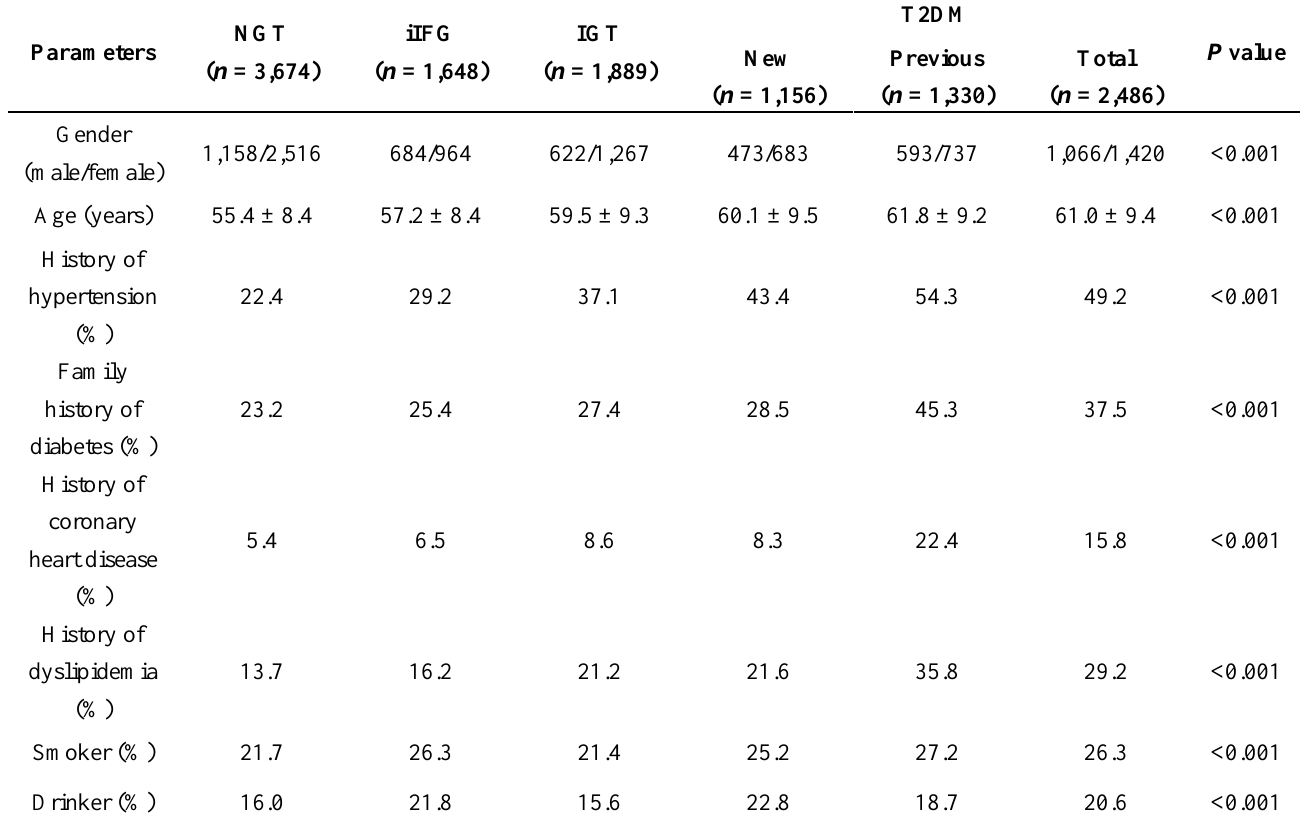
Table 1. Demographic data and hematologic parameters among subjects with different glycemic